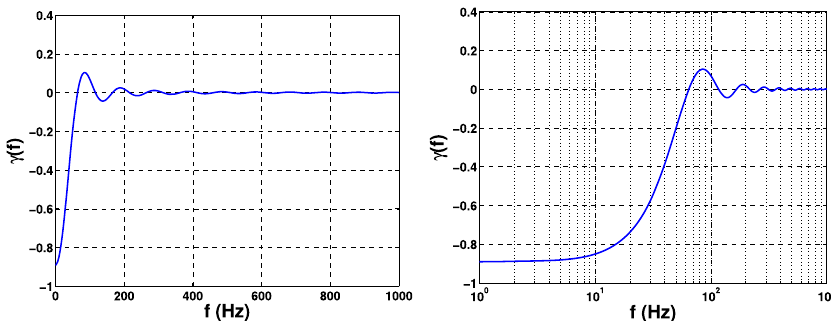
Fig. 34 Overlap function for the LIGO Hanford-LIGO Livinston cross-correlation in the small-antenna limit. Left panel linear frequency scale. Right panel logarithmic frequency scale